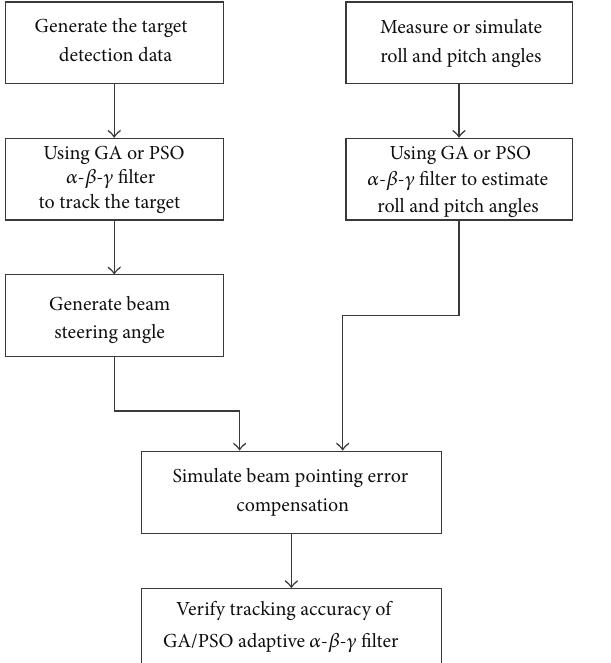
Figure12:FlowchartoftrackingperformancesimulationforCase 4 experiment.